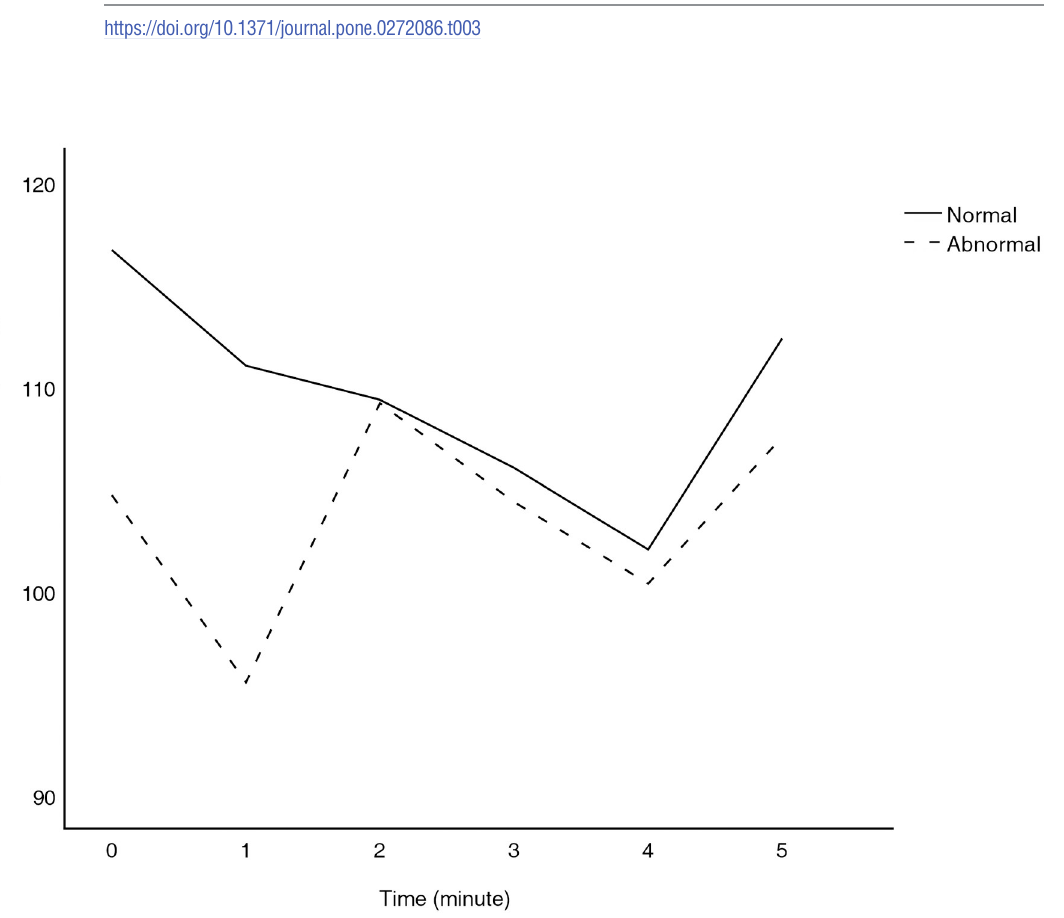
Fig 3. Difference in mean arterial blood pressure fluctuation during the apnea test according to chest radiography findings. The difference in mean arterial blood pressure fluctuations between the two groups was not significant ( P = 0.888).